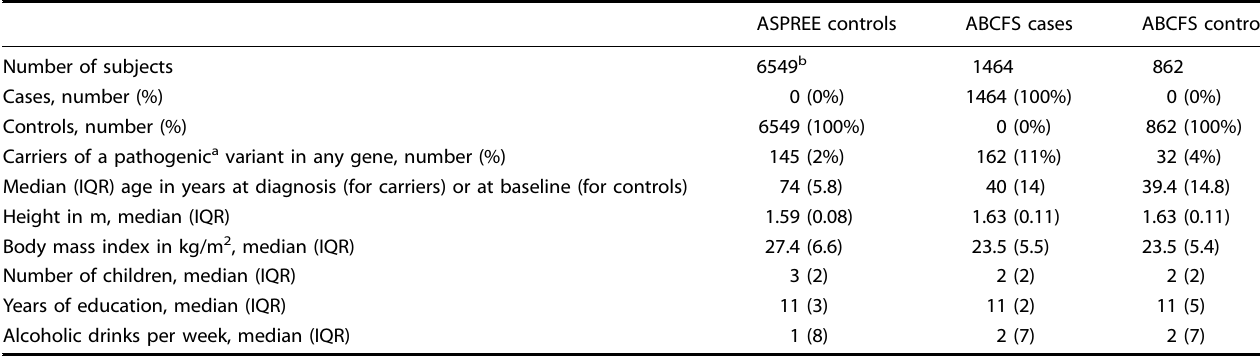
Table 1. Descriptive statistics for the subjects participating in the ASPirin in Reducing Events in the Elderly (ASPREE) study and the Australian Breast Cancer Family Study (ABCFS) included in this study, by breast cancer affected status.